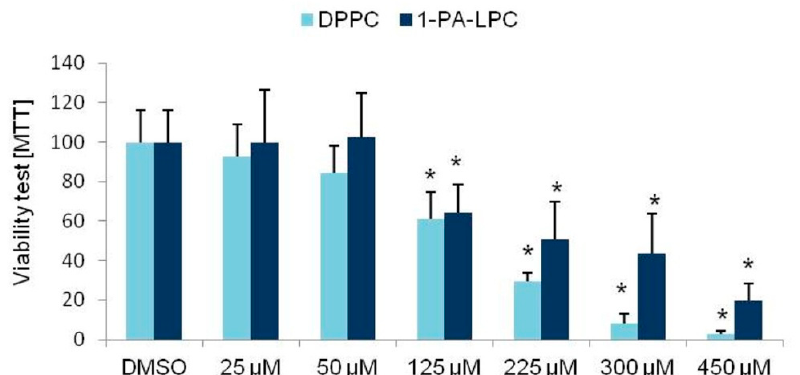
Figure 3. The 3T3 ‐ L1 cells viability with the addition of various concentrations of the compounds used as functional group donors used for the synthesis of the phospholipid derivatives of anisic and cinnamic acids. Student’s t ‐ test, * p < 0.05.